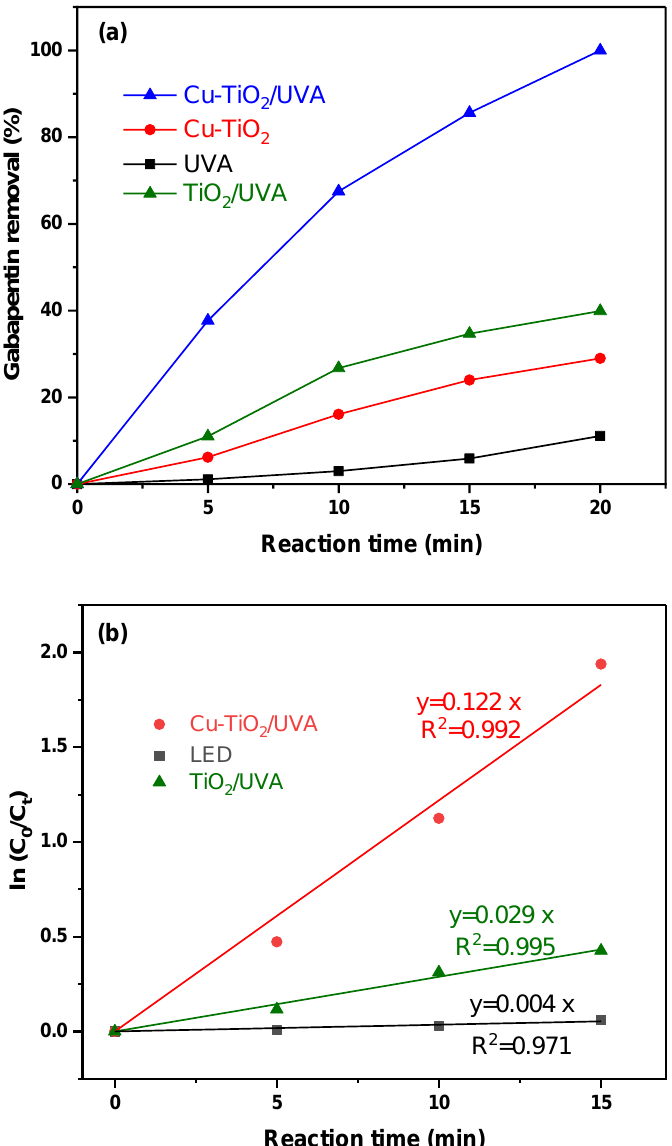
Figure 8. The degradation percentage ( a ) and rate ( b ) of GBP by various processes (GBP = 10 mg/L, pH = 8, catalyst = 0.4 g/L, reaction time = 0–20 min).